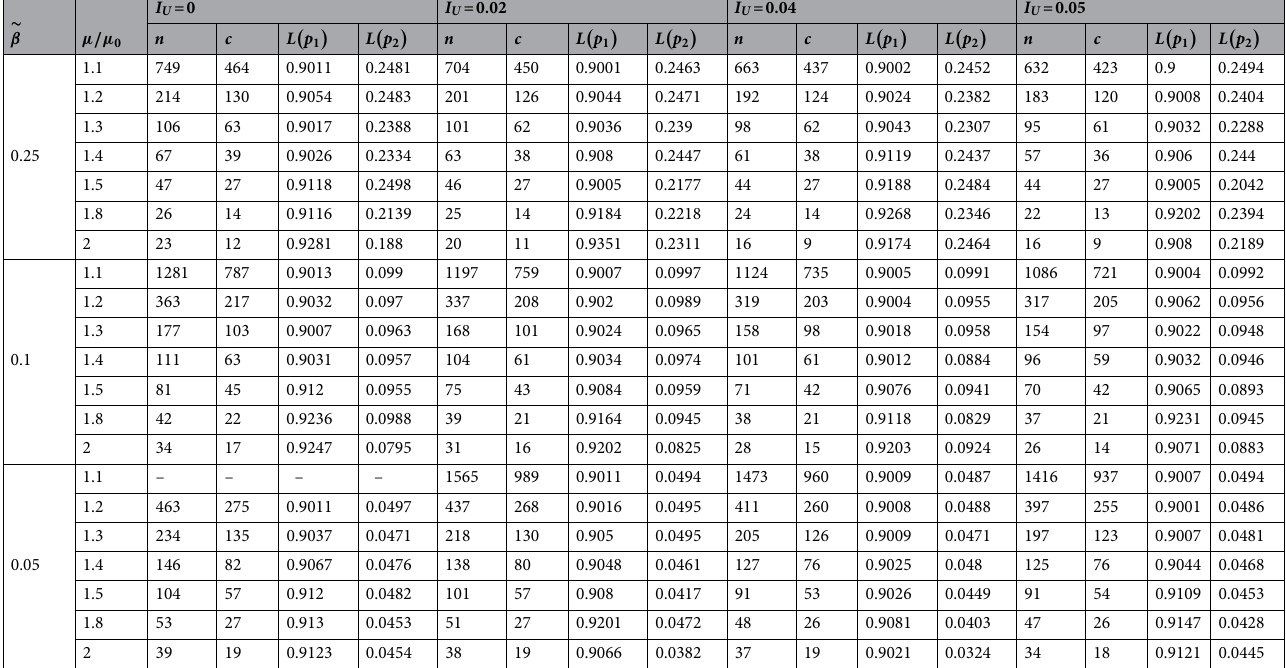
∼ α = 0.10 ; β = 1 and a = 1.0 . (-) denotes parameters do not exist.